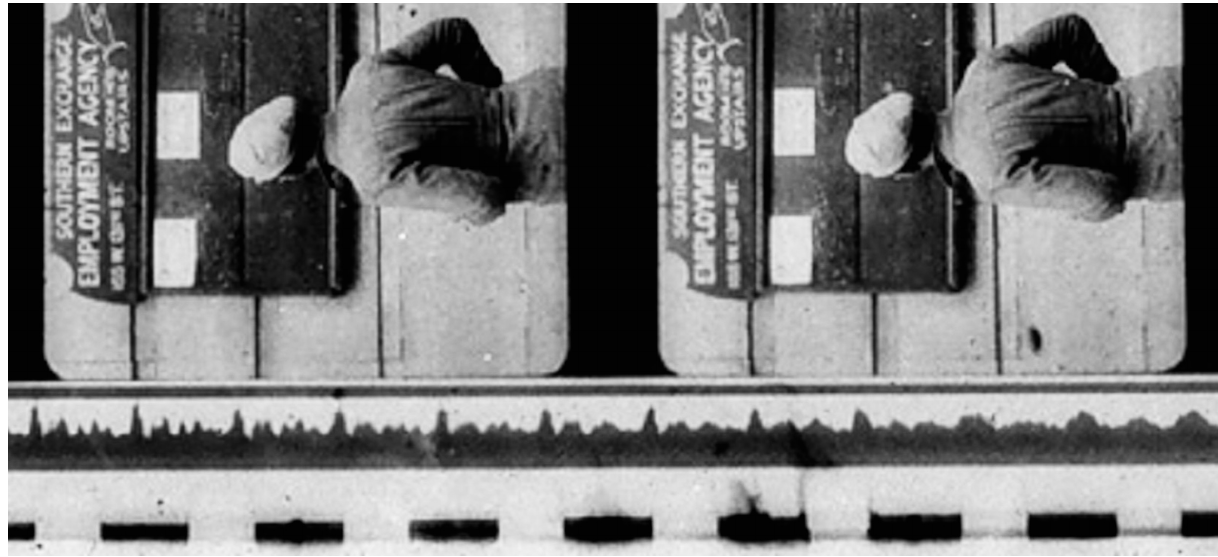
Figure 5: Film frames with accompanying “optical soundtrack,” from the 1937 U.S. Works Progress Administration film, We Work Again . Preserved by the U.S. National Archives and Records Administration. National Archives Identifier: 12322; Local Identifier: